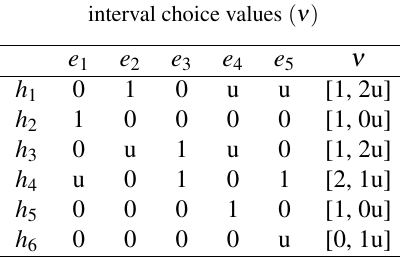
Table 4. An interval soft set ( F , A ) with interval choice values ( ν